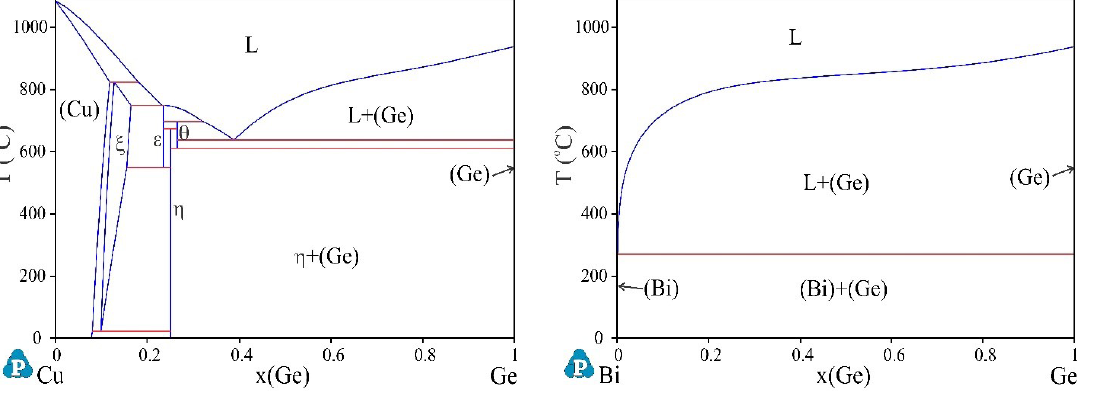
Figure 3. Bi-Ge phase diagram calculated using thermodynamic data established by Chevalier 15